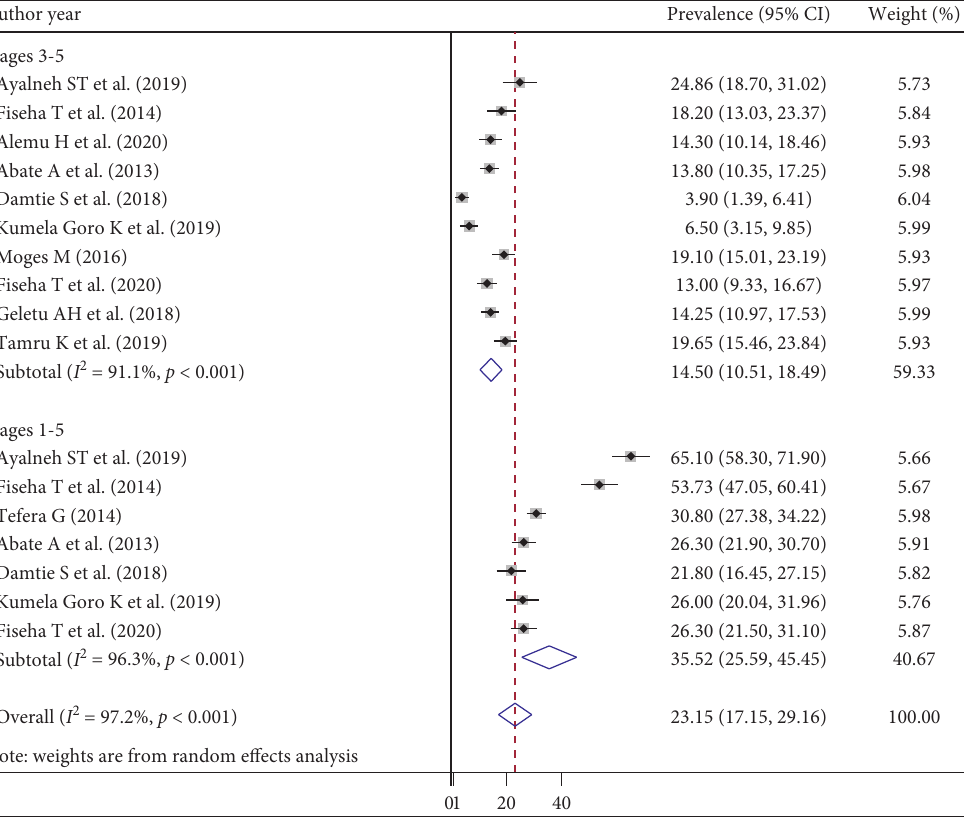
Figure 2: Pooled prevalence of chronic kidney disease (stages 1 to 5 and stages 3 to 5) among diabetes patients. Table 3: The results of subgroup analysis by different categories of the studies.